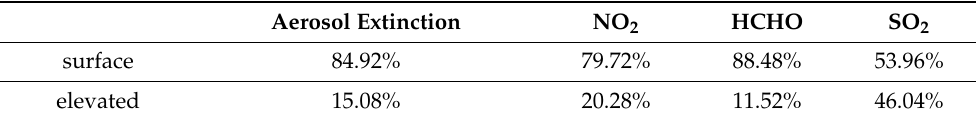
Table A1. Statistics of vertical distribution of various pollutants.